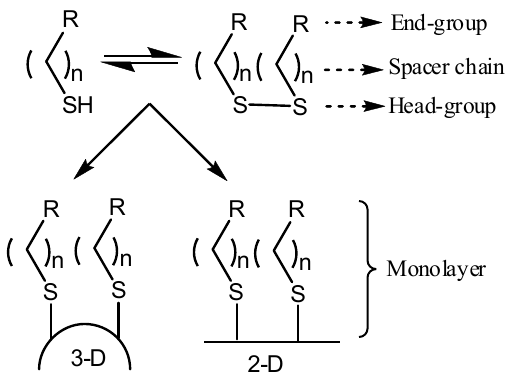
Figure 1. Chemisorption of alkane thiols or disulfides on